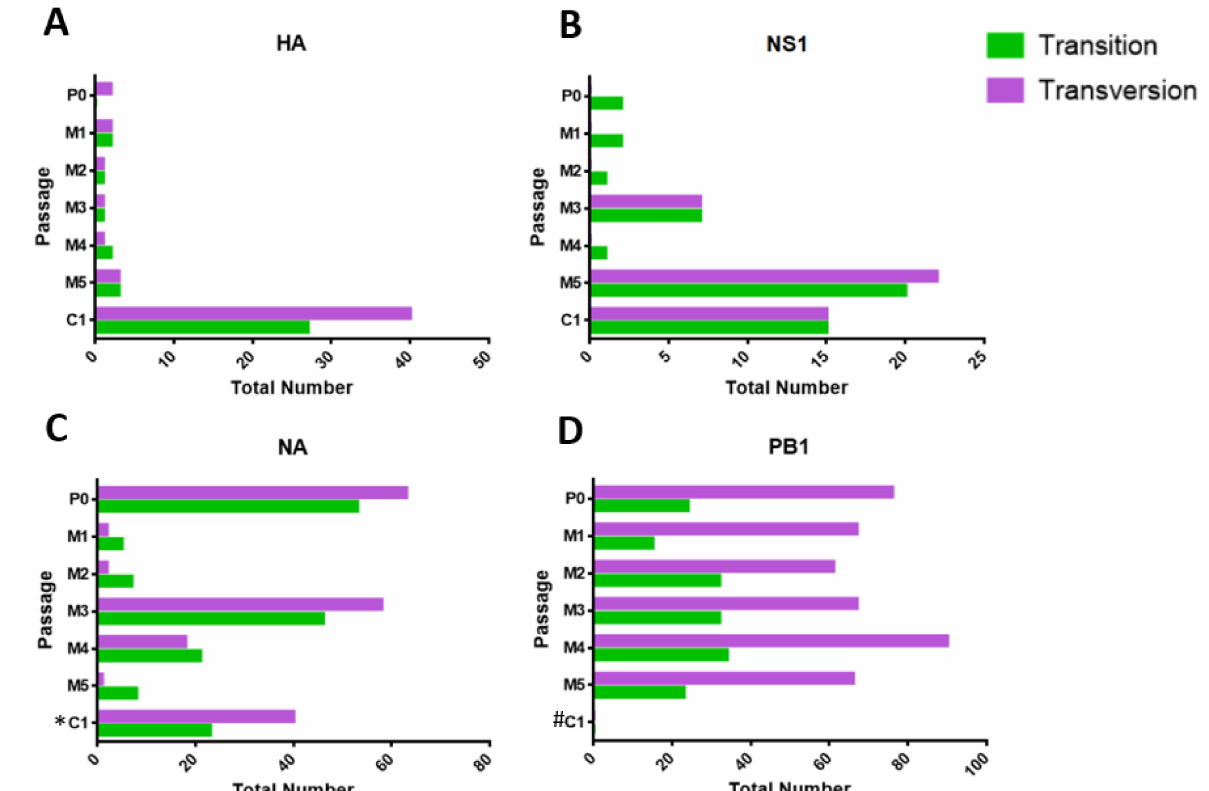
Figure 6. Numbers of transversions and transitions present in P0, MDCK-SIAT1 P1 to P5 (M1 to M5), and CEF P1 (C1) passages for viral genes ( A ) HA, ( B ) NS1, ( C ) NA, and ( D ) PB1. * indicates the number of transversions and transitions in CEF P1 that were only derived from partial NA genes (as full-length NA could not be amplified for this passage). # denotes that the numbers of transversions and transitions were not determined (due to the low quality of sequencing chromatograms for the sample). More details on the viral RNA quasispecies of the various virus passages are available in Supplementary File